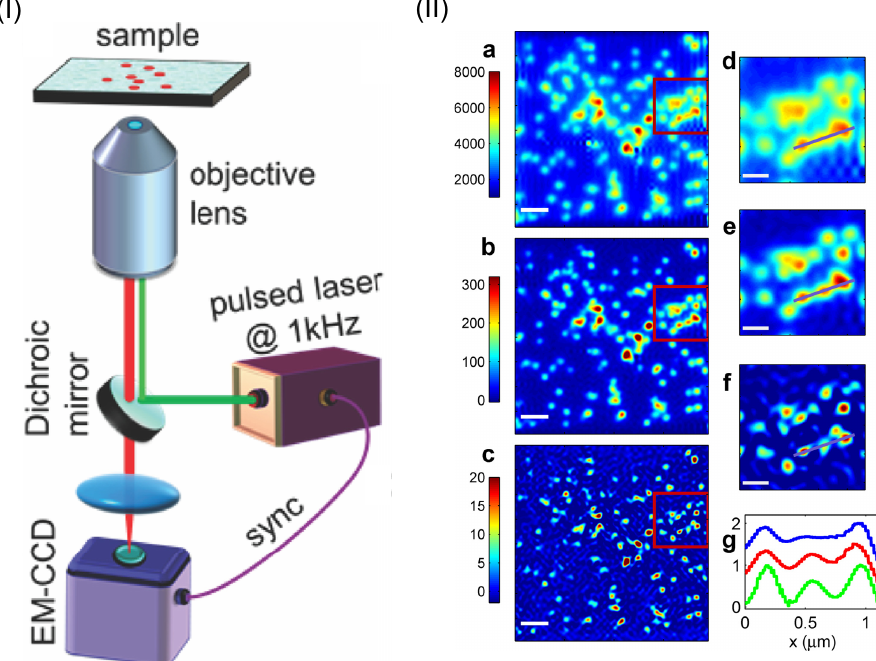
Figure 5. ( I ): Schematic of the experimental setup for realizing super-resolution image based on antibunching effect of quantum single-photon emitters. The sample to be imaged consists of many independent single-photon emitters. Multi-photon coincidence counts are measured with an EMCCD camera. ( II ): Super-resolution images measured with second-order ( b ) and third-order ( c ) antibunching effect, which clearly show the resolution enhancement in comparison with the conventional intensity image ( a ). Scale bars in ( a – c ): 1 µ m. ( d – f ) are zoom-in images of the zones marked by red box in ( a – c ), while ( g ) shows the one-dimensional plot of the cross-sections marked by the solid line in ( d – f ). Scale bars in ( d – f ): 400 nm. The figure is reproduced with permissions from Ref. [37] of